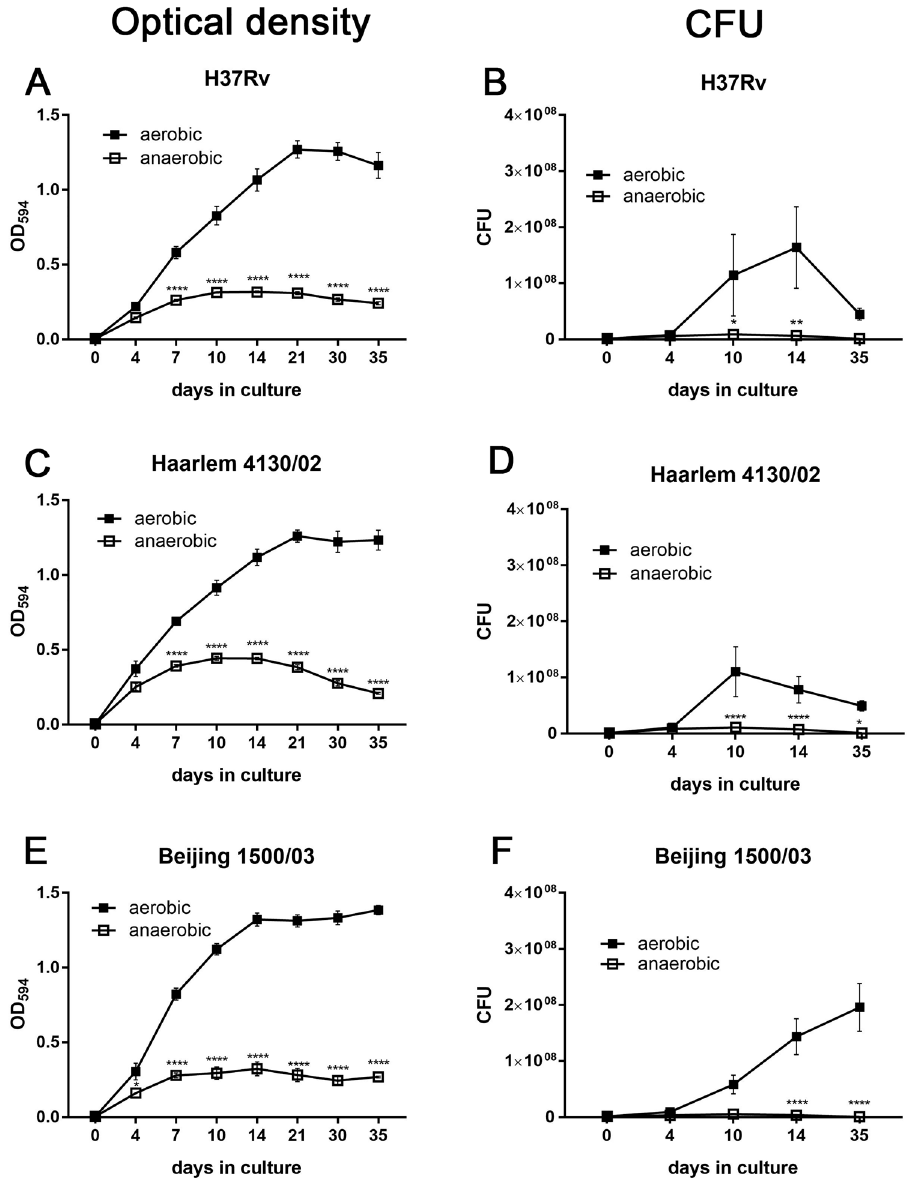
Figure 1. O 2 depletion-induced dormancy in H37Rv (L4), Haarlem (L4) and Beijing (L2). Approximately 2 × 10 6 (OD = 0.004) mycobacteria were cultured with or without O 2 . At indicated time points, OD was measured ( A , C , E ) or bacteria were plated for CFU analysis ( B , D , F ). O 2 depletion led to reduced bacterial growth in all examined strains (H37Rv, Haarlem, Beijing). n = 4 (H37Rv, Beijing), n = 3 (Haarlem) independent experiments with triplicates in each, ****p < 0.0001, **p < 0.005, *p < 0.05, two-way